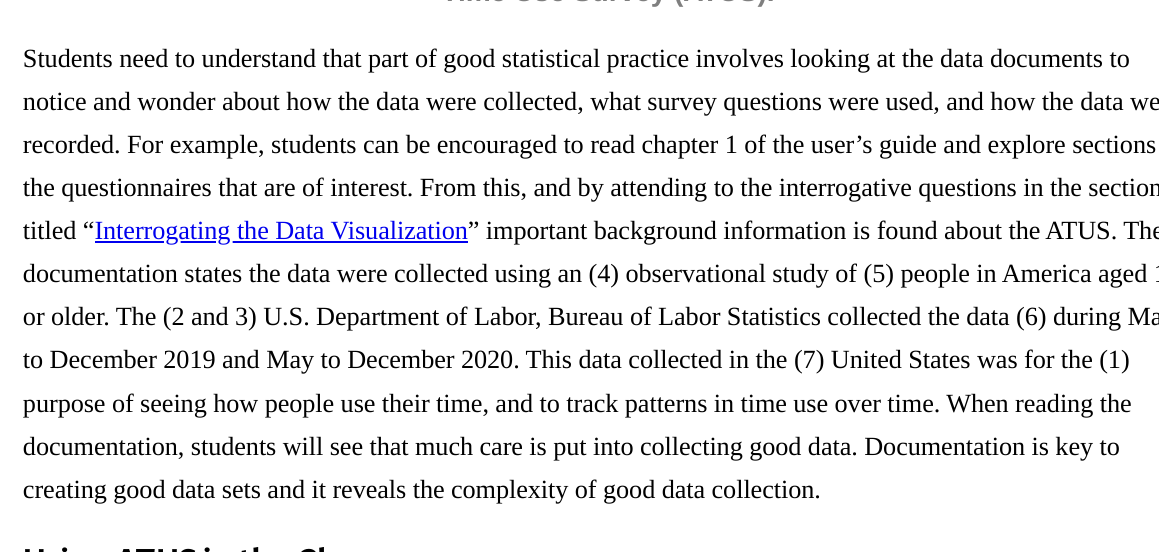
Figure 2. Ten different documents that are available on the U.S. Department of Labor, Bureau of Labor Statistics website that discuss the data provenance for the American Time Use Survey